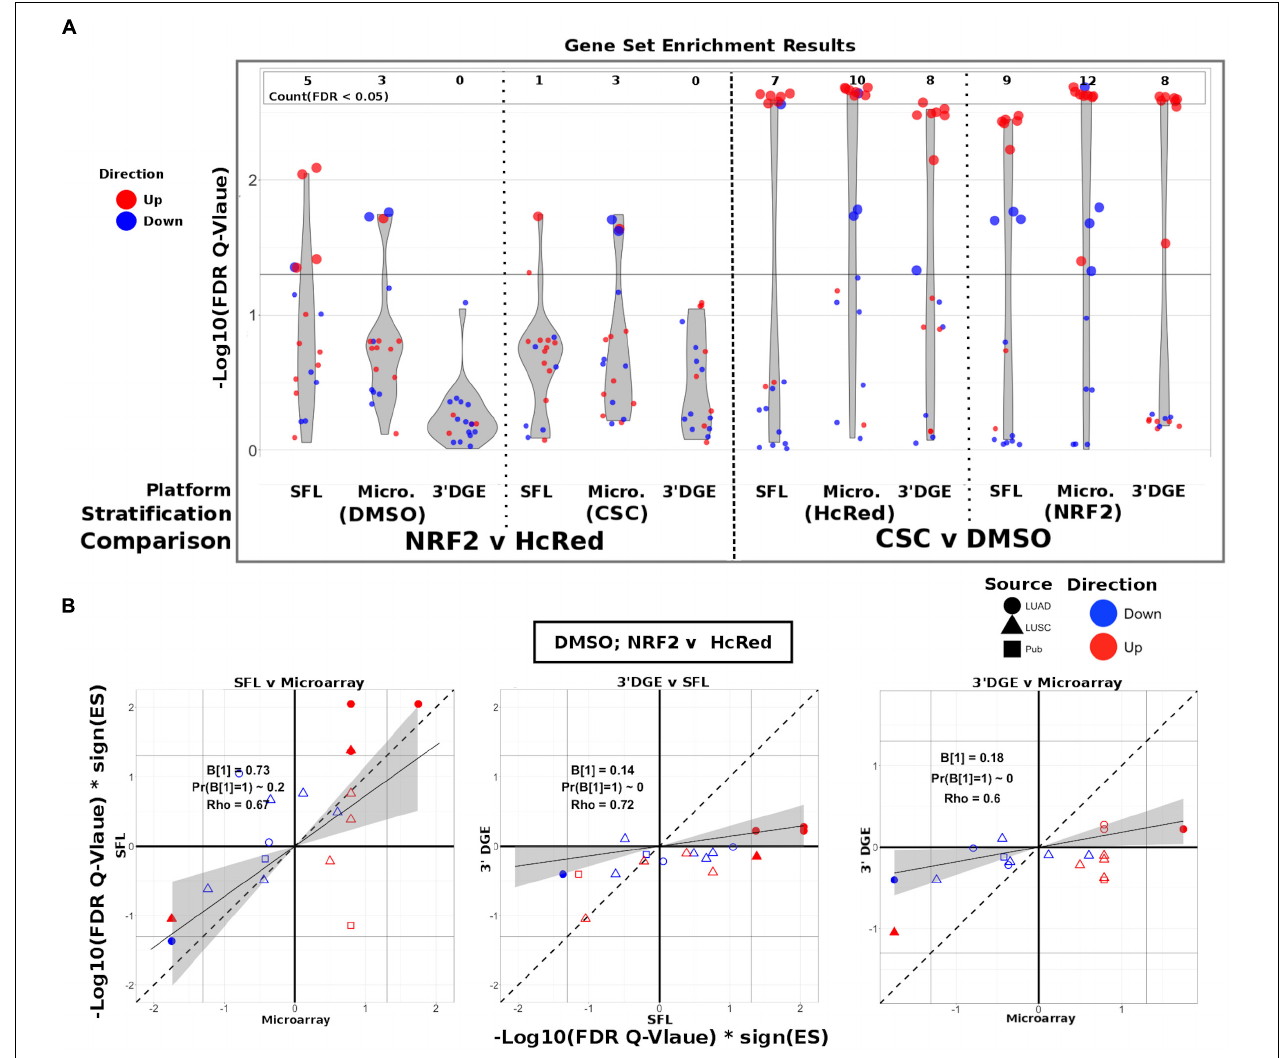
FIGURE 4 | Comparison of gene-set enrichment of smoking and gene mutation signatures across SFL, 3 (cid:48) DGE and microarray. (A) Violin plots of the –Log10(FDR Q -Value) from gene set enrichment analysis of TCGA-derived gene-sets with respect genotypic perturbations (left) and chemical perturbations (right) differential signatures across like samples within SFL, Microarray, and 3 (cid:48) DGE. Each column corresponds to differential signatures comparing genotypic or chemical perturbation groups, stratified by a single chemical or genotypic perturbation group, respectively, e.g., the left-most column shows the enrichment results with respect to the “DMSO-treated; NRF2 vs. HcRed” signature within the samples ( stratum ) in SFL data. Specific results for TCGA-derived genes sets are shown in Supplementary Figure S7 . (B) Comparison of the gene set enrichment results between SFL, microarray and 3 (cid:48) DGE with respect to the “DMSO-treated; NRF2 vs. HcRed” differential signature. Shown are the transformed FDR Q -values of the TCGA-derived gene sets corresponding to mutations of NRF2 and CNA of KEAP1. The | –Log10(FDR Q -Values)| corresponding to the FDR < 0.05 significance thresholds are shown as vertical and horizontal gray lines for the y and x -axes, respectively. Points of gene sets whose enrichment meets this threshold in either of the two platforms are filled in. Colors and shape of points denote direction and source of the gene set, respectively. Additional results for chemical and genotypic perturbation signatures are shown if Supplementary Figure S8